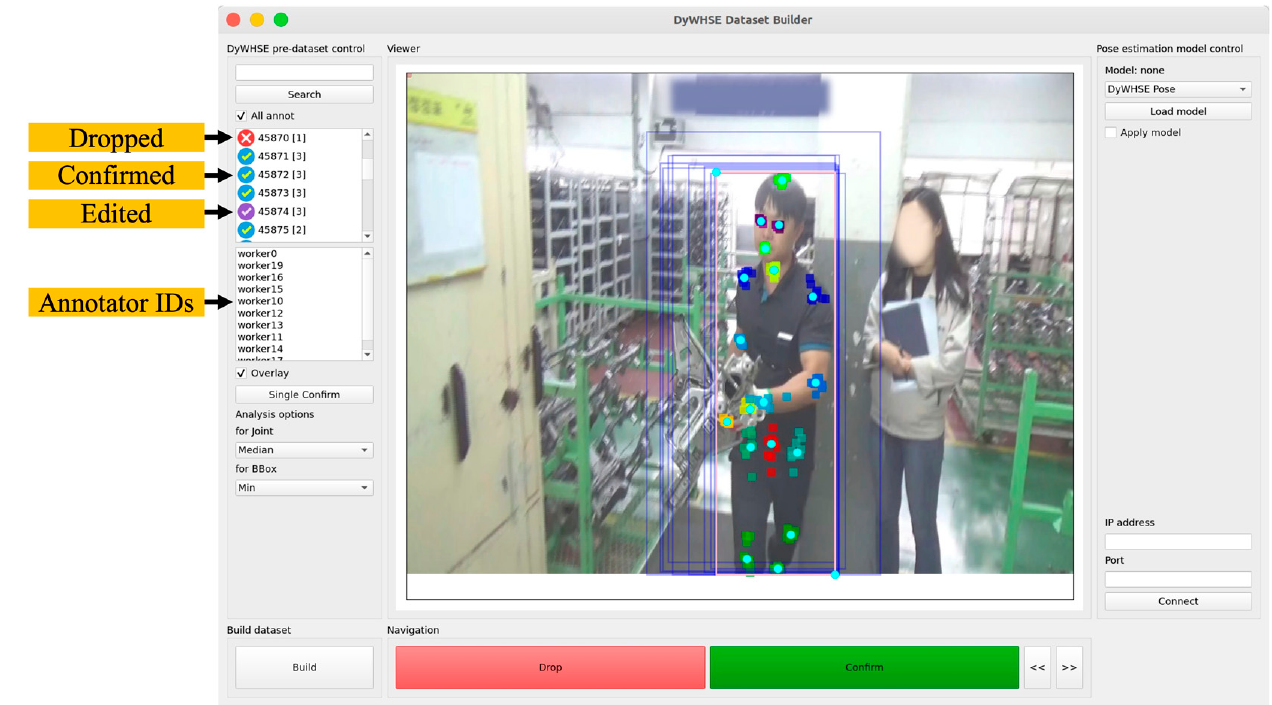
Figure 8. DyWHSE dataset builder.